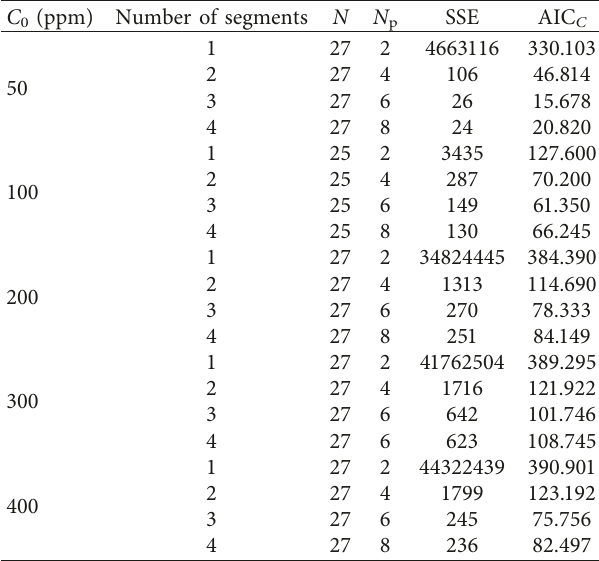
0.5g; pH 7.0; room 1000mL; m MIL-101 (cid:30) (cid:30) (cid:30) Table 2: Comparison of piecewise models of one, two, three, and four linear segments using AIC for Weber’s